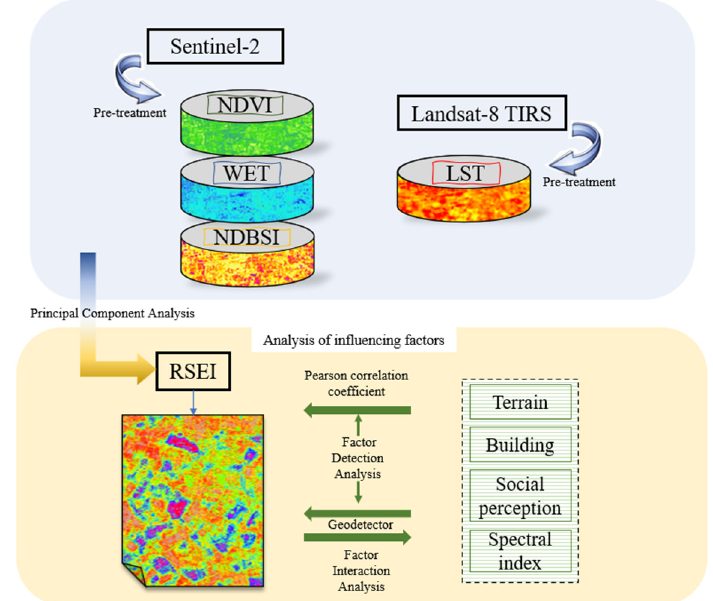
Figure 2. The roadmap of